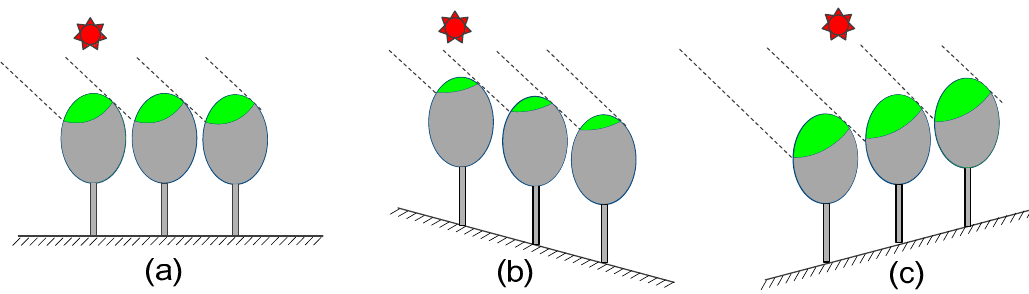
Figure 8. Canopy shadow cast on flat and sloped forest. ( a ) Flat forest. ( b , c ) Sloped forest. The dotted lines represent the incident solar beam.